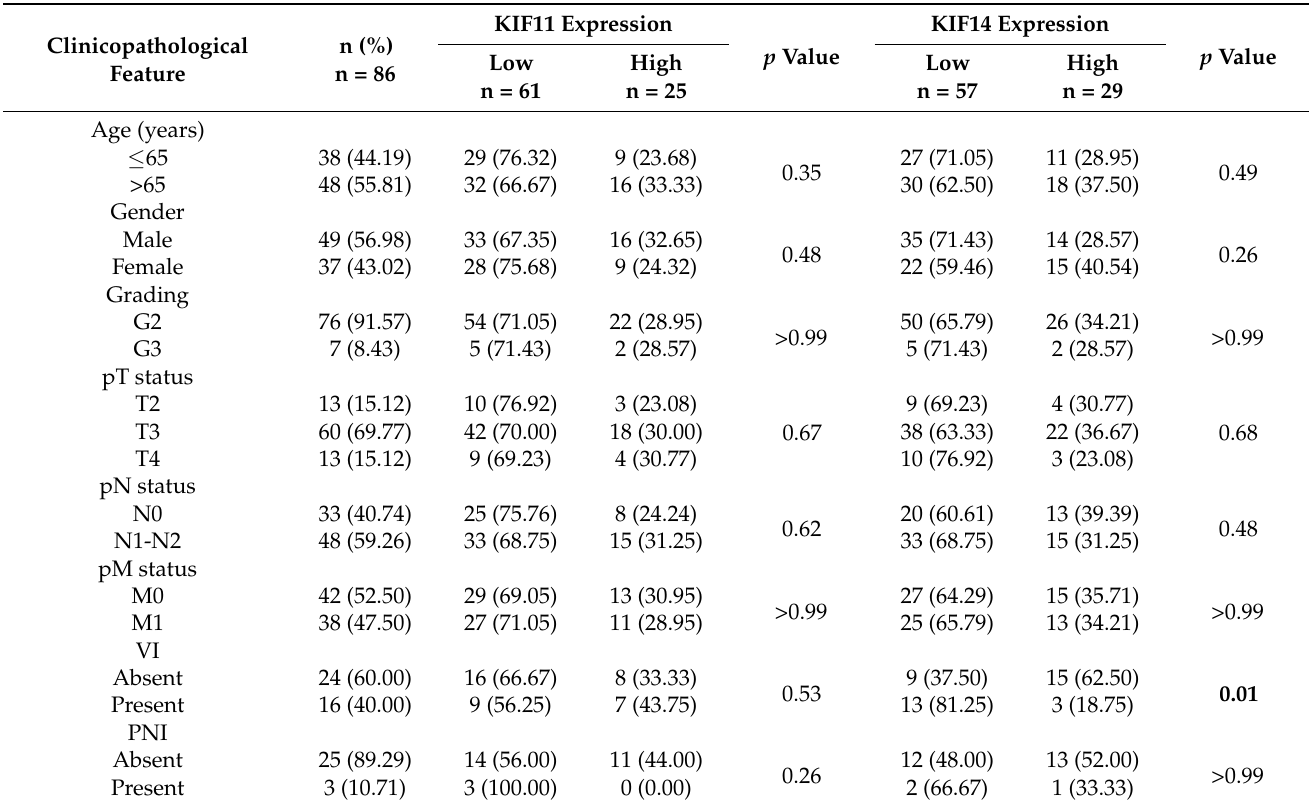
Table 1. Association of KIF11 and KIF14 protein expression in colorectal cancer with patient characteristics.